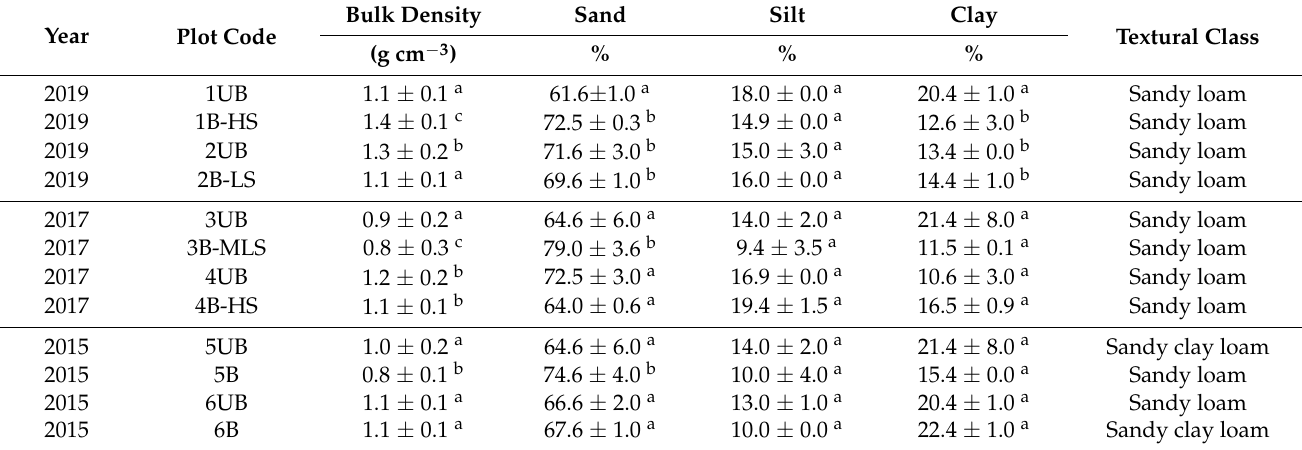
Table 2. Mean values of the physical properties of the soil for the different HMs, including their standard deviations (12 repetitions for each HM). Different letters mean significant difference among burning scenarios within each study year ( p < 0.05, Tukey